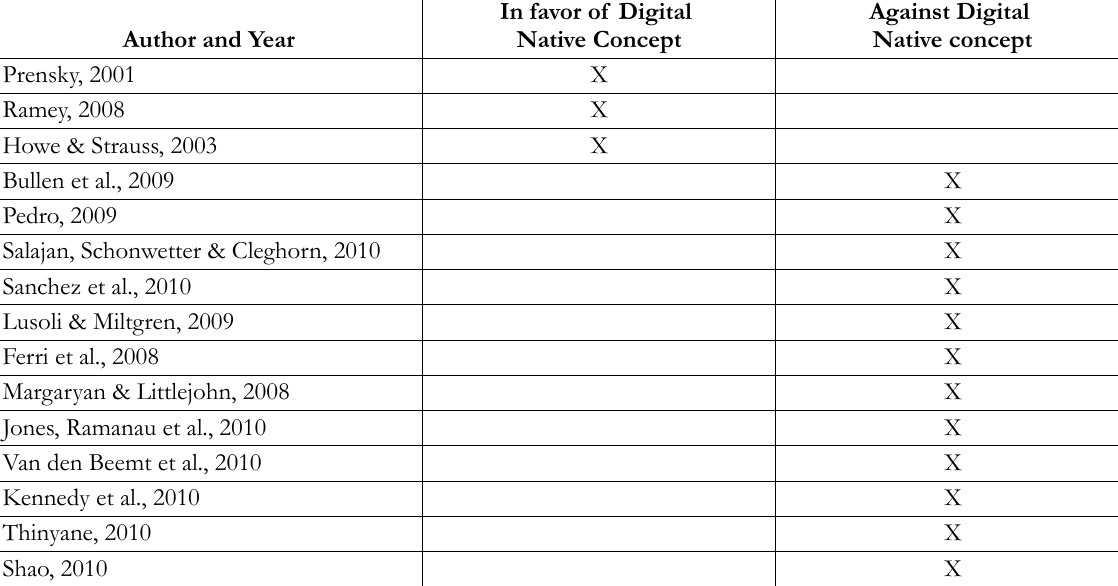
Table 2. Table showing summary of studies in favor and against students fitting with the digital native